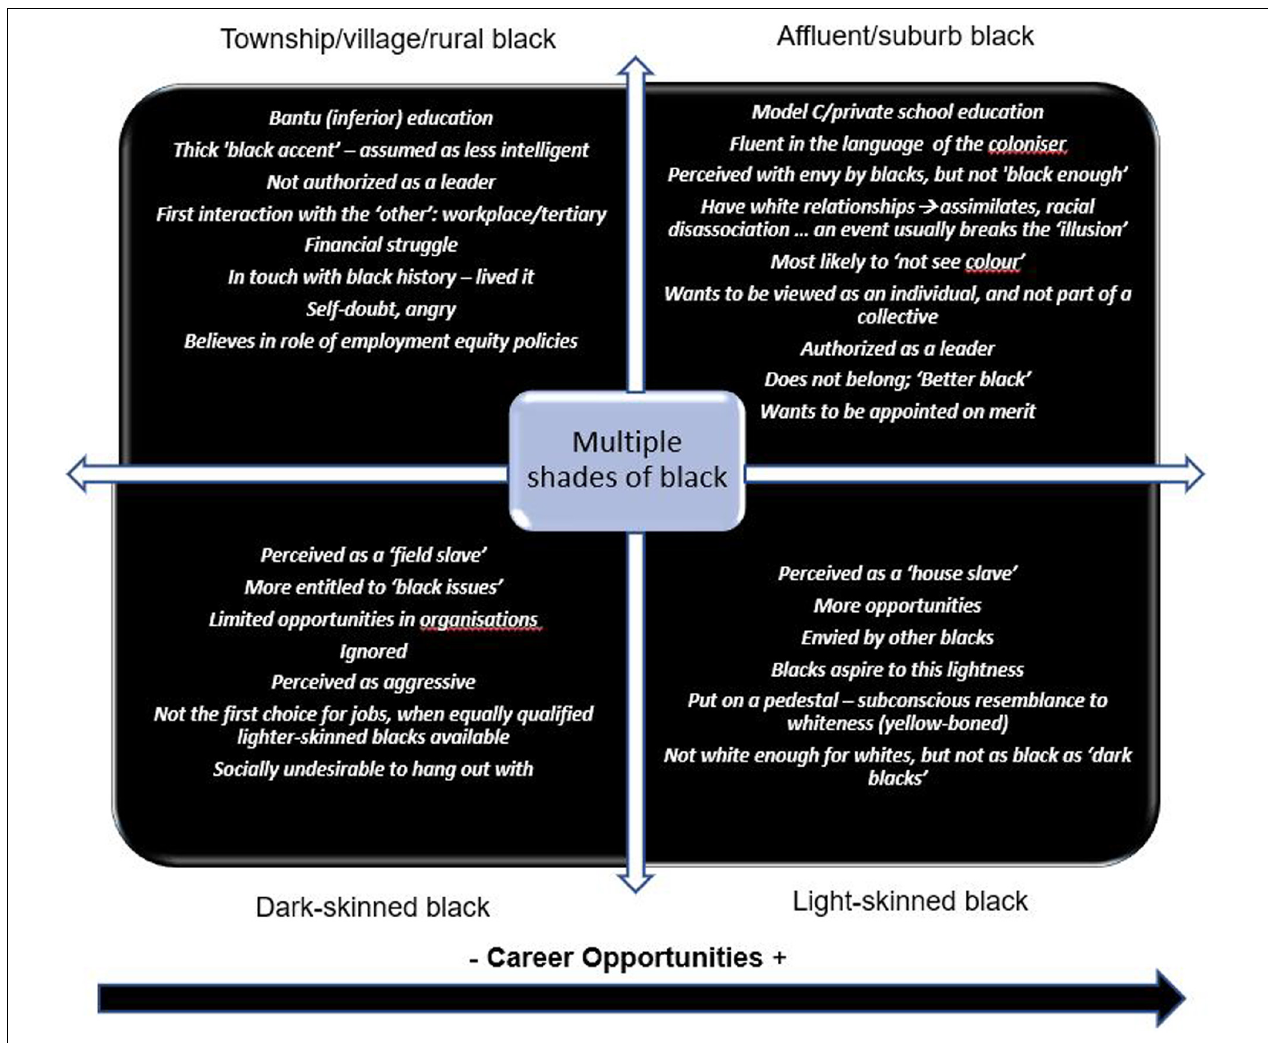
FIGURE 3 | Classification of black